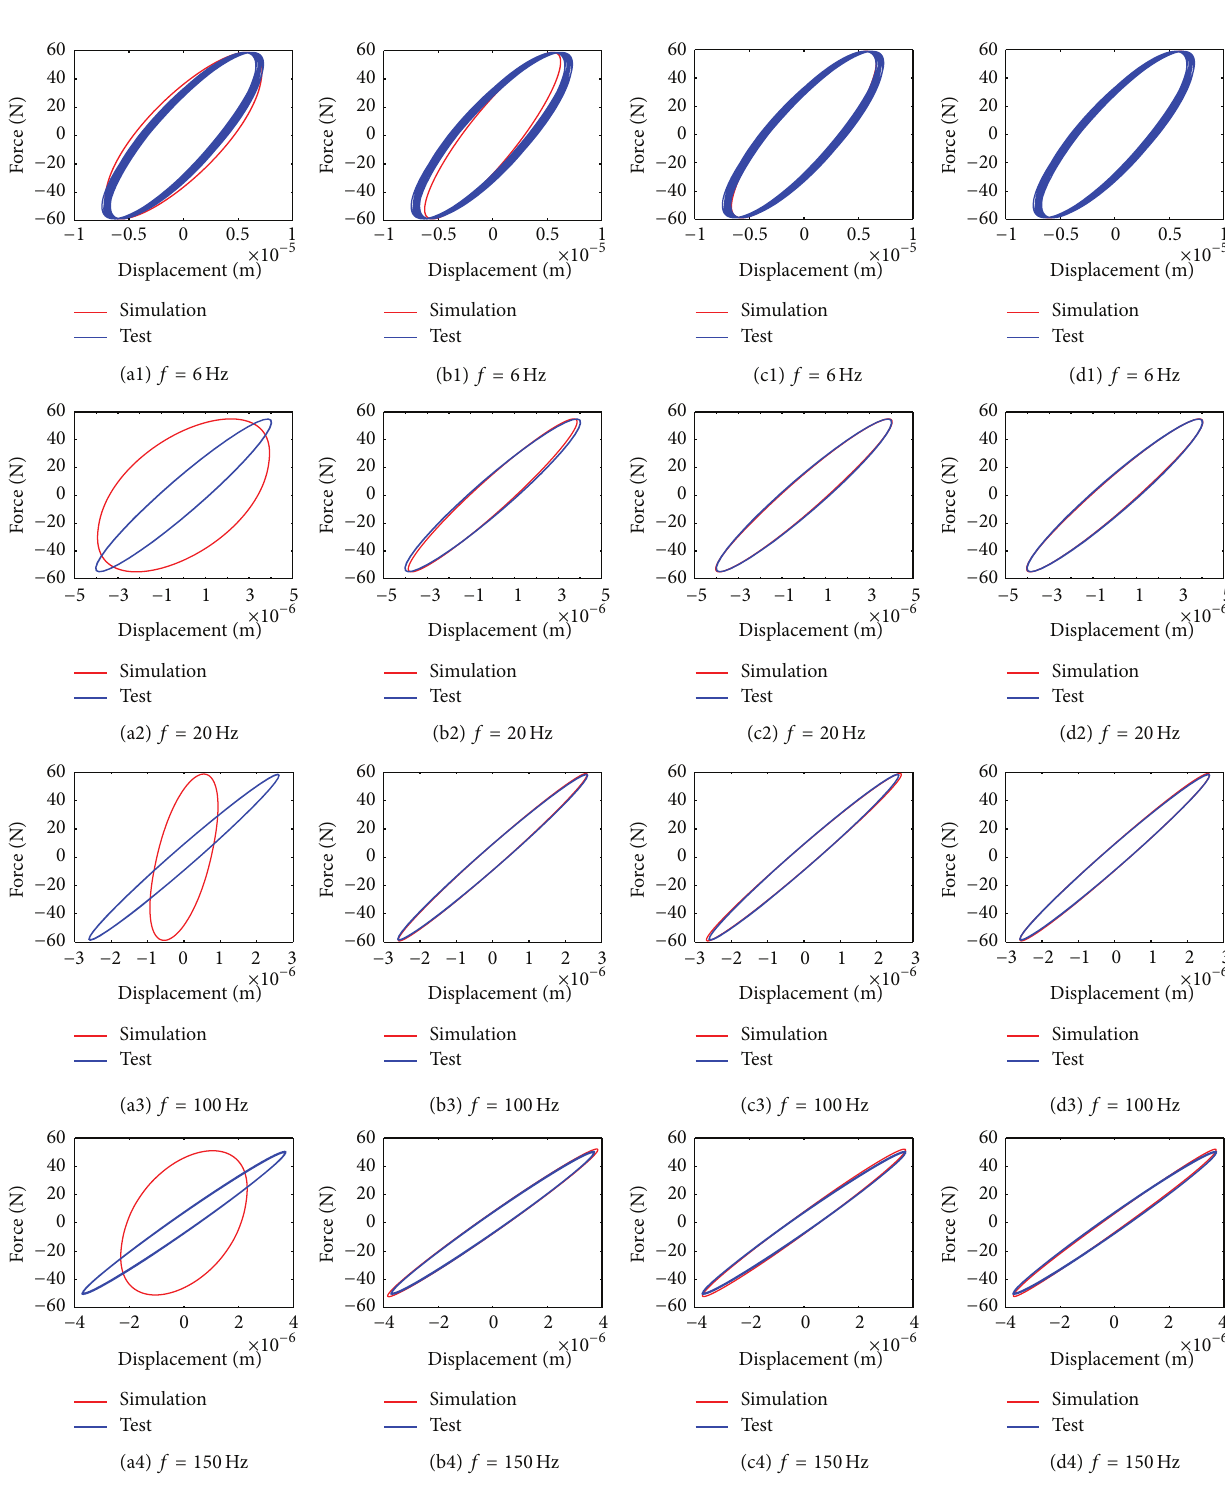
Figure 9: Comparisons of hysteretic loops between simulation and test. (a) Simple model. (b) Linear Maxwell model. (c) GNM. (d)